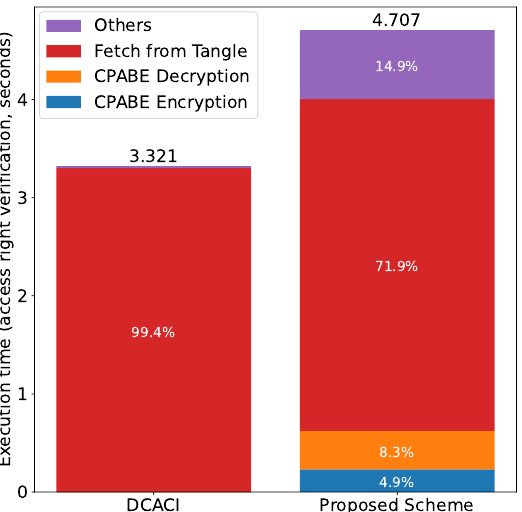
Figure 25. Comparison with DCACI: access right